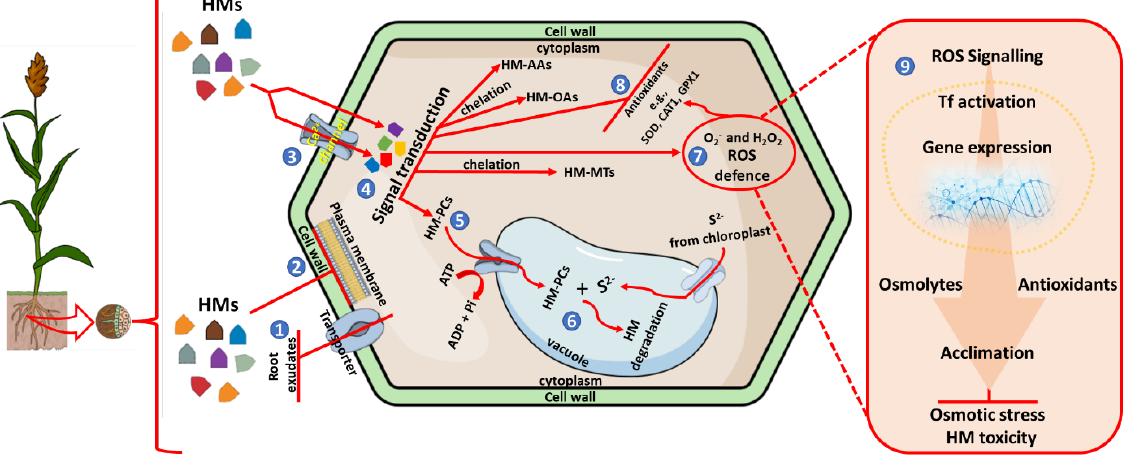
Figure 1. Schematic representation of plants’ response to heavy metals and induced osmotic stress. Plants growing in HM-contaminated soils can prevent HM uptake by (1) releasing root exudates that form insoluble complexes with metal ions, and (2) reduction of metal influx across the plasma membrane. Metal ions influx can still occur through the Ca 2+ channels and the plasma membrane into the plant cell (3), MAPK-mediated signal transduction (4), occurs to induce the expression of metal chelating ligands in the cytosol to form complexes such as HM-AAs (amino acids), HM-OAs (organic acids), HM-MTs (metallothioneins) and HM-PCs (phytochelatins). HM-PC complexes are transported through the tonoplast into the vacuole by ATP-binding-cassette and V-ATPase transporter (5), which are further complex with sulfides from the chloroplast for degradation (6). The perception of HMs is amplified by the signalling transduction to induce ROS defence and oxidative stress (7), this leads to the activation of antioxidants (8) and (9) to combat oxidative damage, osmotic stress, and HM toxicity.